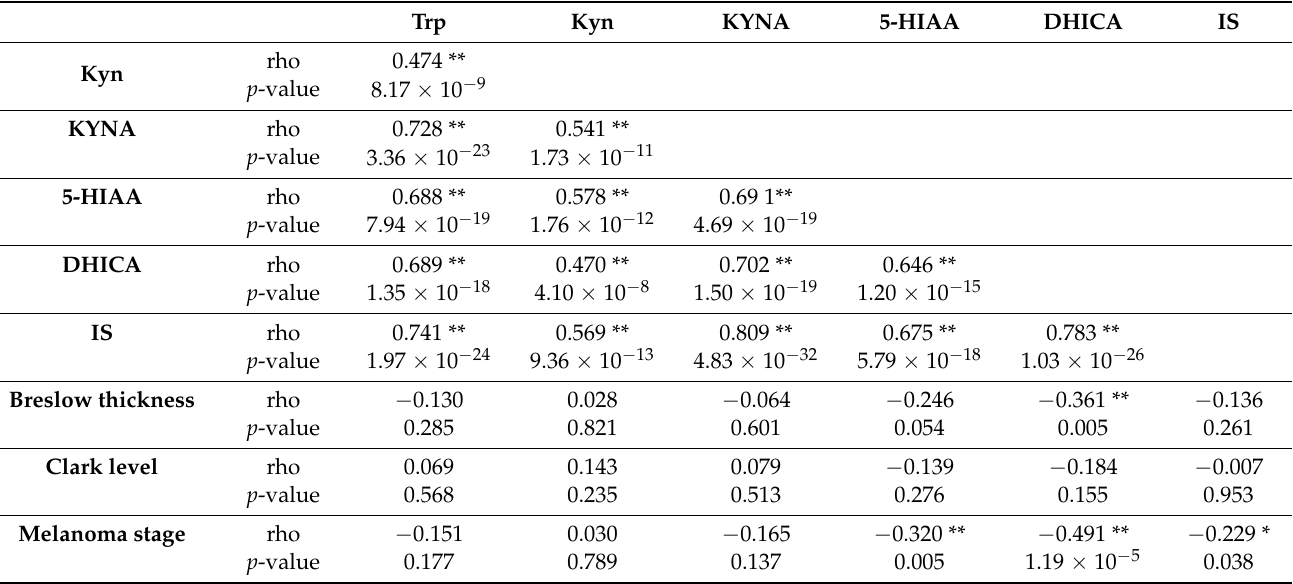
Table 5. Nonparametric correlation between the studied parameters, the Breslow thickness, Clark level, and the melanoma stage.